Question: Looking at the figure, what chart type is it?
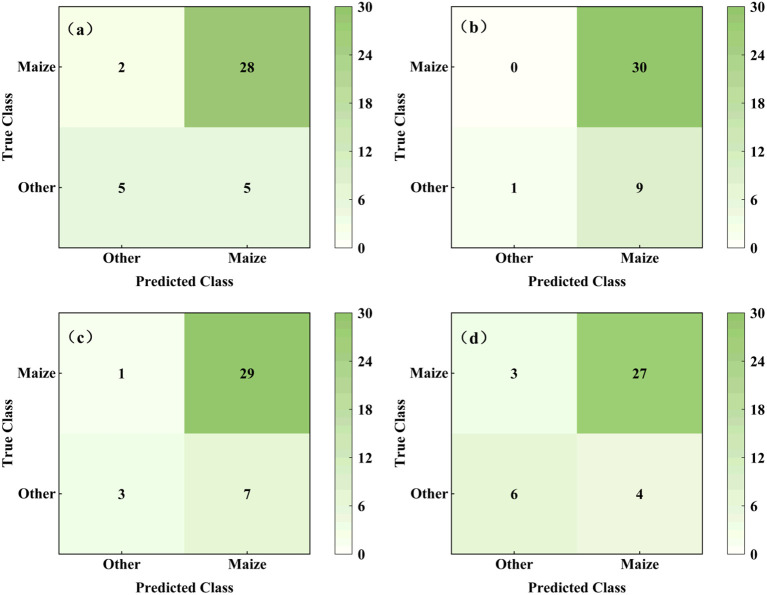
Answer: heatmap